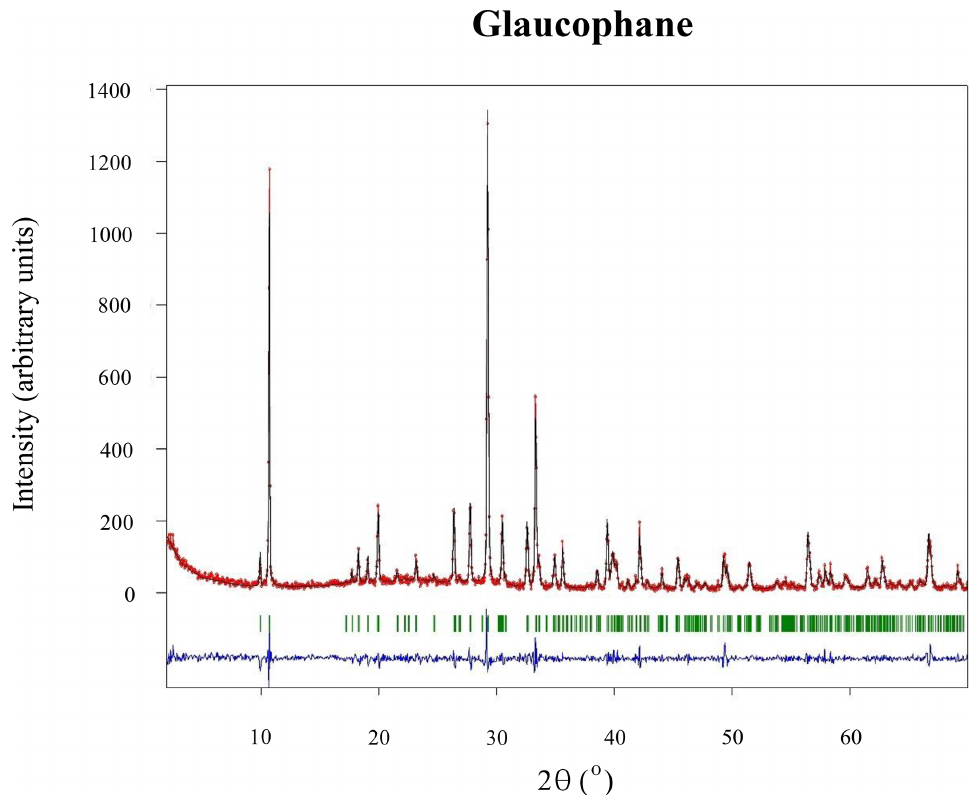
Figure C1. Observed (red points), calculated (black line), and difference (bottom blue line) X-ray powder diffraction pattern for the studied glaucophane sample. Bragg peak positions are given as vertical green